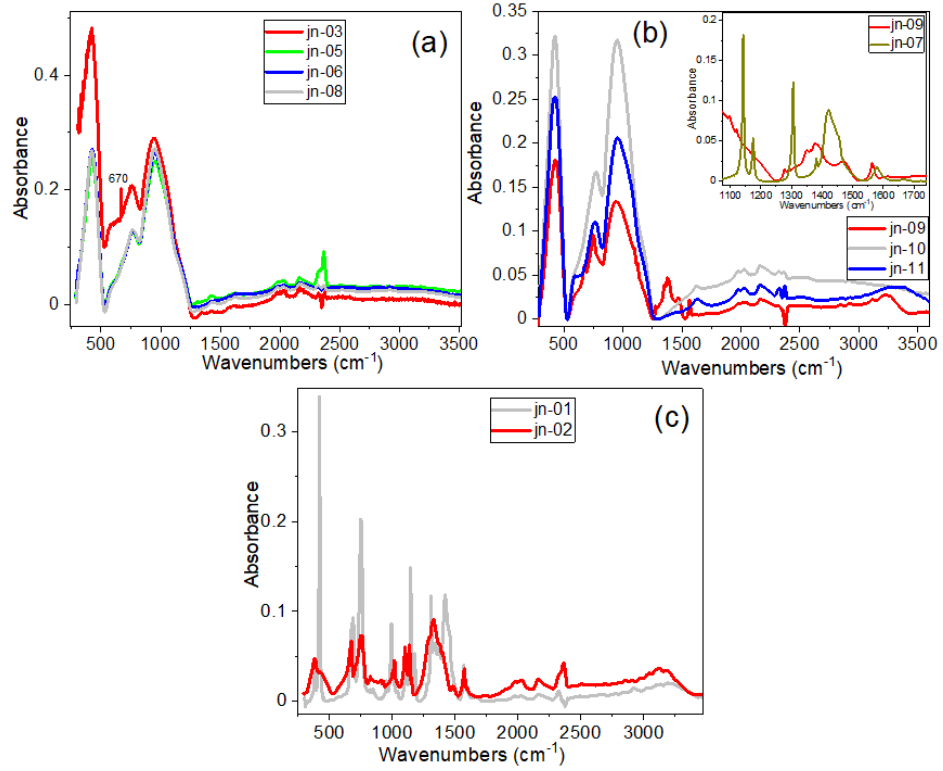
Figure 3. ( a ) FTIR spectra of ZIF ‐ 8/67 with MCG plates; ( b ) FTIR spectra of ZIF ‐ 67 ‐ 2 + MCG e (jn ‐ 09 ‐ red) in comparison with the bare MCG with (MCG u —blue) and without (MCG e —grey) HF treatment. Inset shows comparison between FTIR spectra of ZIF ‐ 67 ‐ 2 + MCG e and powder ZIF ‐ 67 ‐ 2 in the region 1073–1742 cm − 1 ( c ) FTIR spectrum of ZIF 8 powder sample with MCG u composite sample. (Note: the subscripts “u” and “e” represent unetched and etched MCG, respectively). Comparison of the FTIR spectrum of the ZIF ‐ 67 ‐ 2 powder sample (sample jn ‐ 07),